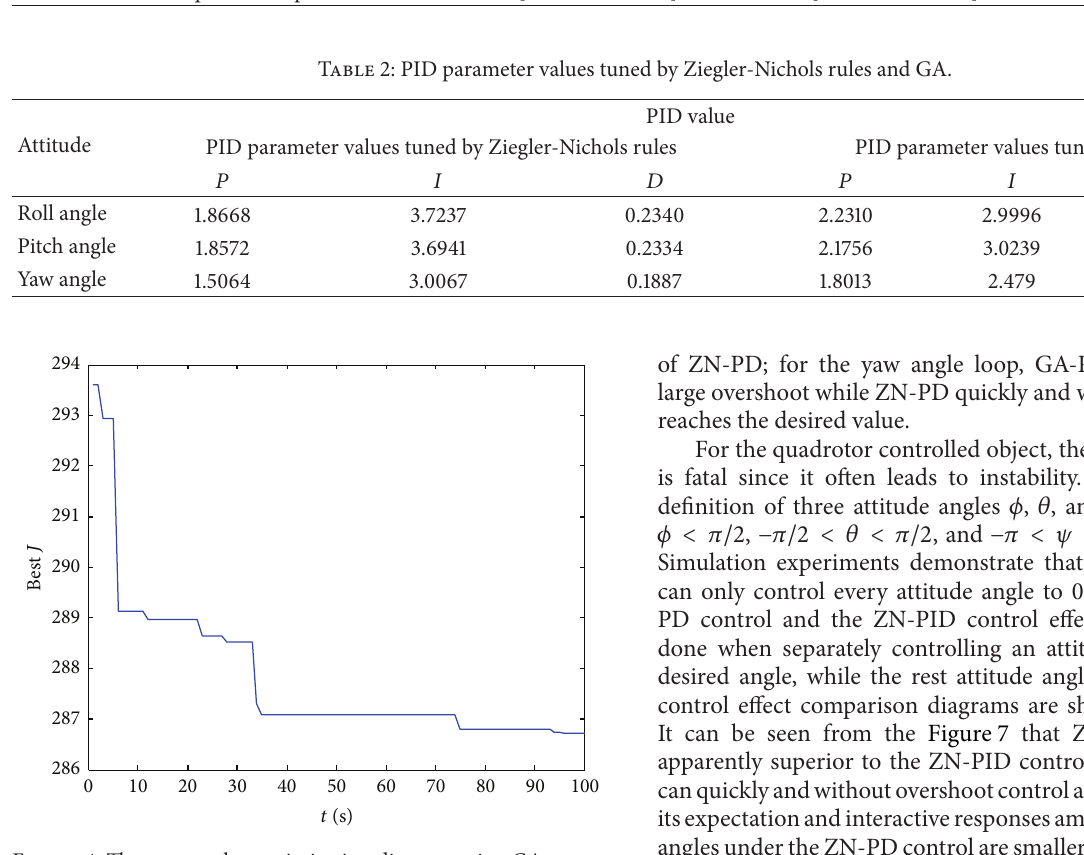
Figure 4: The target value optimization diagram using GA to tune PID parameter values of roll angle